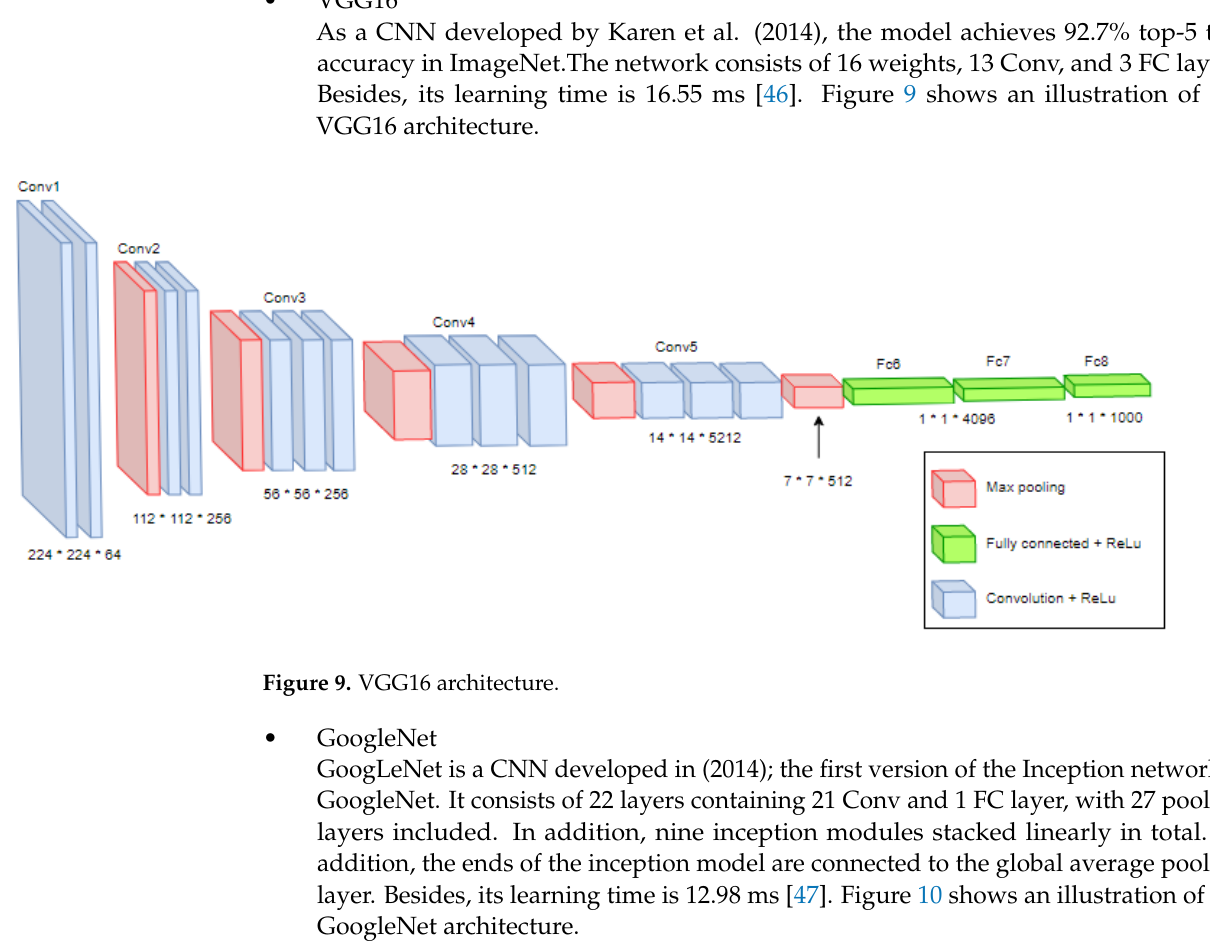
Figure 8. AlexNet architecture.